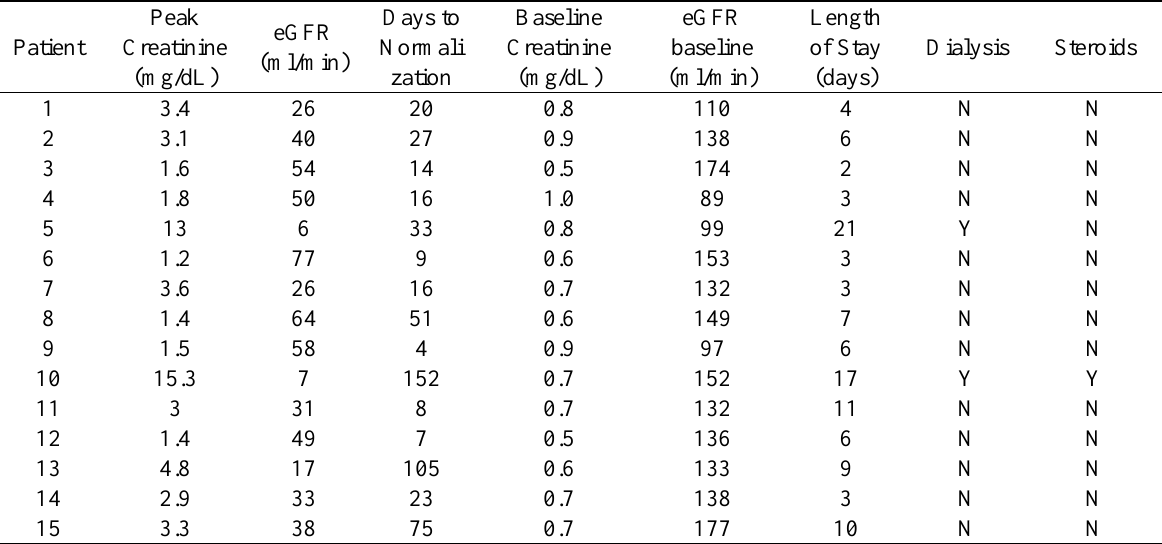
Table 2. Outcome of 15 inpatients with NSAID induced